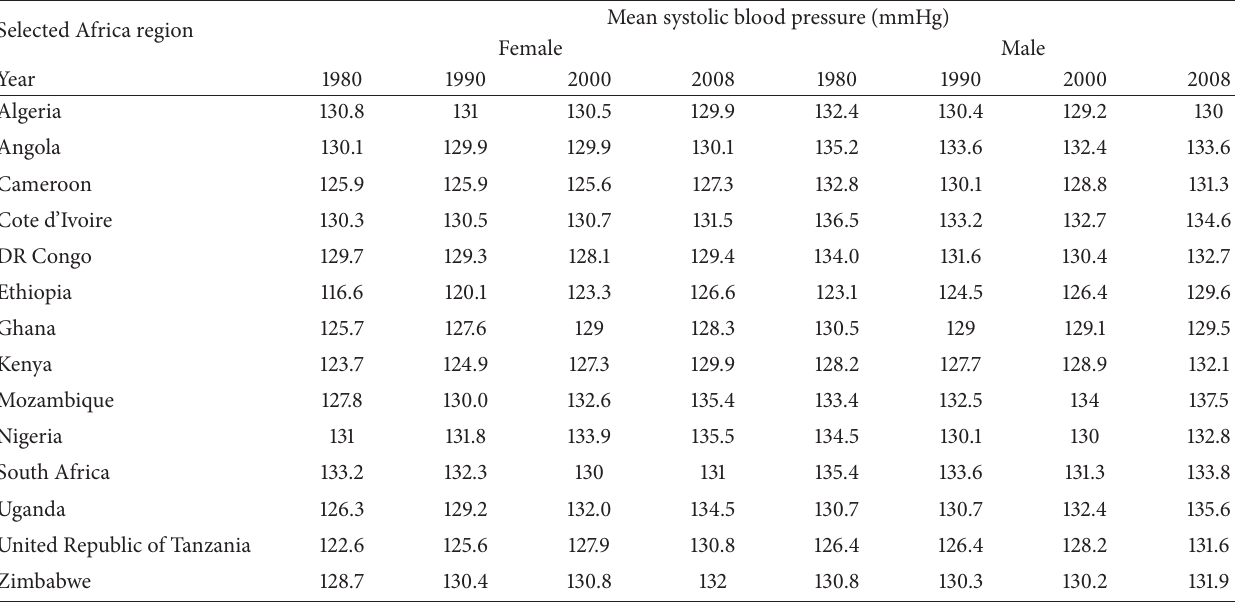
Table 3: Trends in age-standardized mean SBP in selected Africa region between 1980 and 2008 for male and female population [6]. Selected Africa